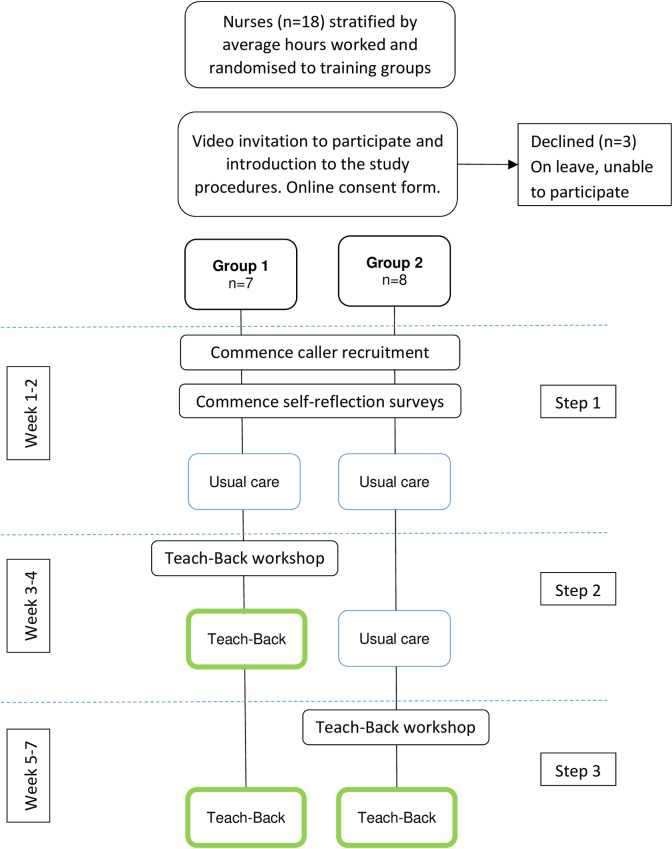
Flow chart of nurse (cluster) study activities.